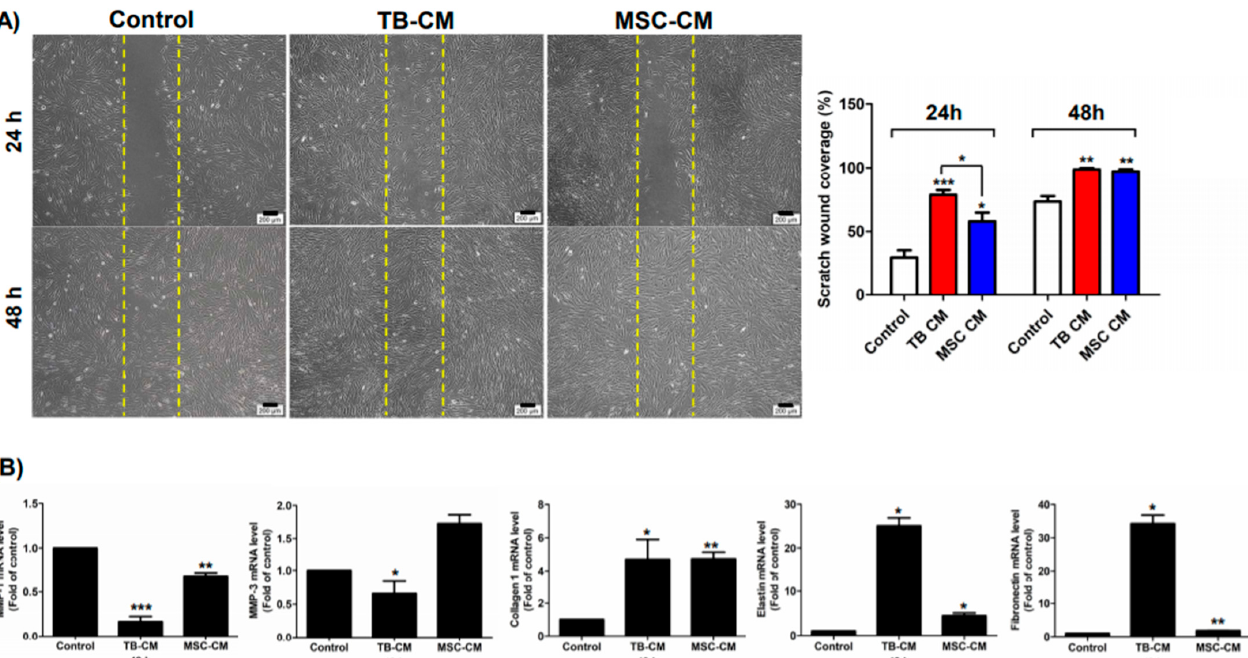
Figure 2. TB-CM induced the migration of HNDFs. ( A ) HNDF cells were scratched and then treated with 20% TB-CM and/or MSC-CM in serum-free media. After incubation for 24 and 48 h, the migrated cells were stained and visualized under a light microscope. Scale bar: 200 µ m. The area of migration was quantified for each group using ImageJ and is represented as a graph. ( B ) The expression levels of genes encoding for MMP-1, MMP-3, collagen type I, fibronectin 1, and elastin were determined using quantitative real-time RT-PCR post-treatment of scratch-wounded HNDFs with 20% TB-CM and MSC-CM for 48 h. Data are represented as means and SD; * p < 0.05, ** p < 0.01 and *** p < 0.001, as compared to the corresponding